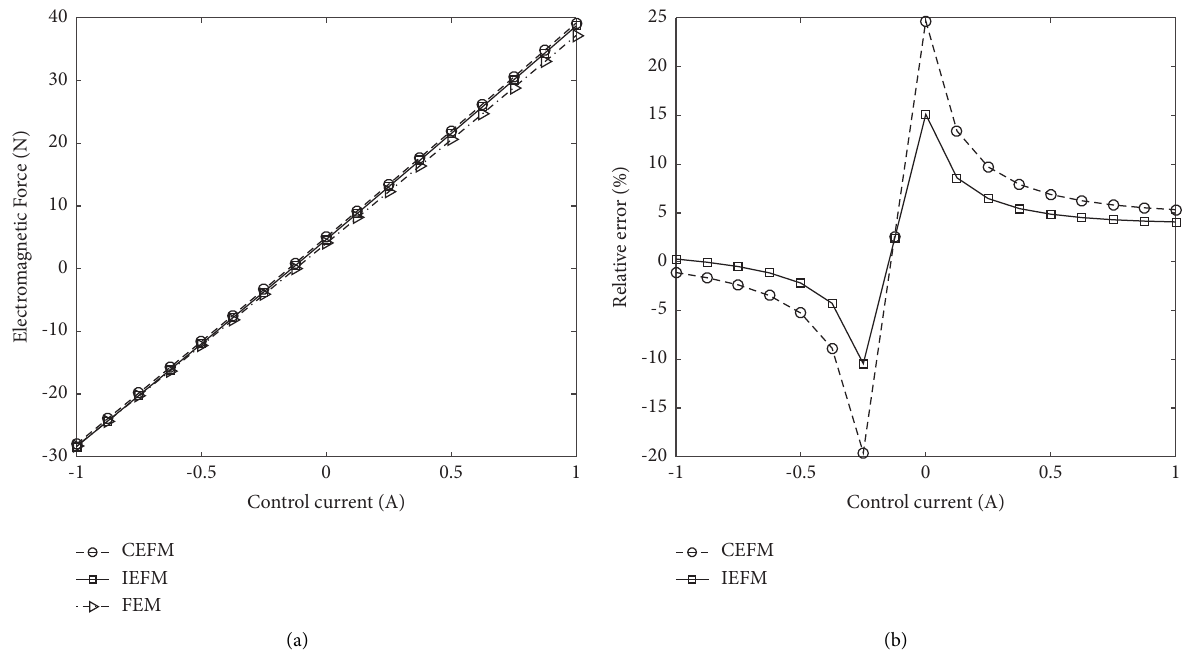
Figure 3: Result comparison between IEF and CEF with different control current. (a) Electromagnetic force. (b) Relative